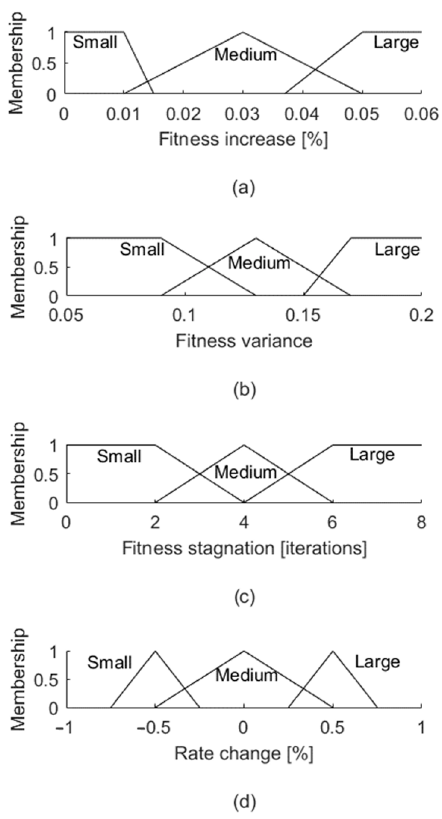
Figure 12. ( a ) CF membership functions. ( b ) VF Membership functions. ( c ) UF membership functions. ( d ) Δ pm and Δ pc membership functions.